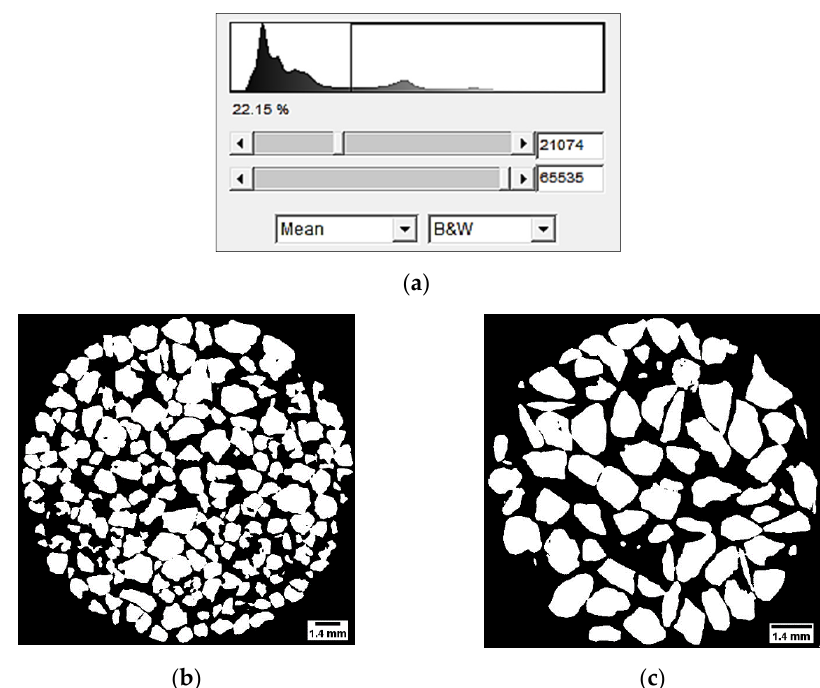
Figure 18. Image processing: ( a ) Grey-level histogram; ( b , c ) Tomographic cross-sectional view of HN1.25/1.6 and GLAG1.25/1.6 at their initial condition (before test).